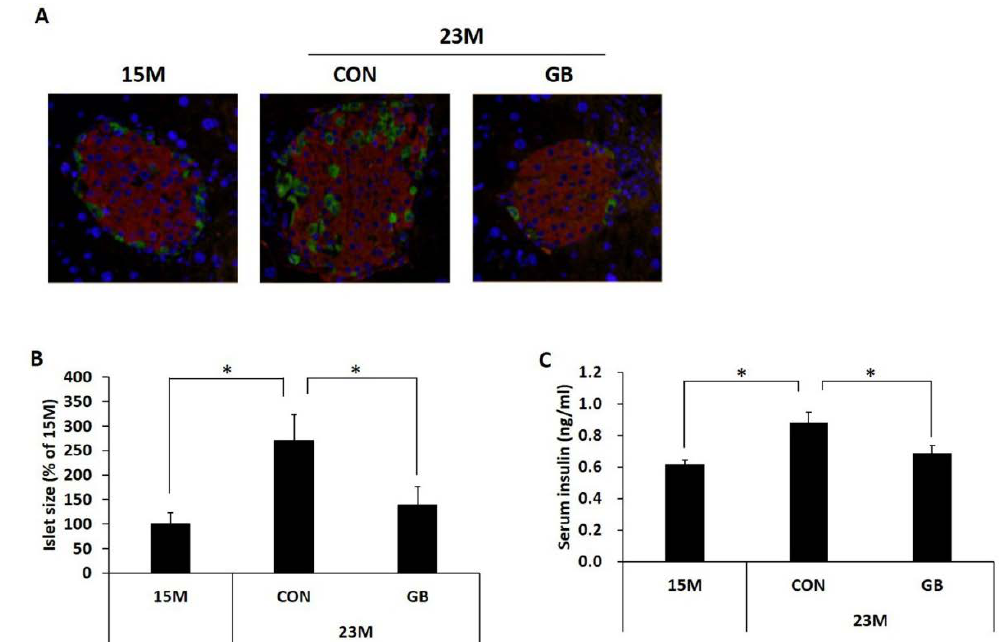
Figure 4. Ginseng berry (GB) extract supplementation decreases serum insulin levels and ameliorates pancreatic islet hypertrophy in aged mice. Fifteen-month-old mice were fed a regular diet (CON) or regular diet supplemented with 0.05% ginseng berry extract (GBD) for 8 months. At 23 months of age, the pancreas was removed and ( A ) pancreatic sections were stained with anti-insulin (red) and anti-glucagon (green) antibodies. Nuclei were fluorescently labeled with 4’,6-diamidino-2-phenylindole (DAPI) (blue); ( B ) Islet size was measured at 23 months of age (≥25 islets were measured from each mouse, n = 5 group −1 ); ( C ) Non-fasting serum insulin level was measured at 23 months of age. Values are means ± SE. * p <